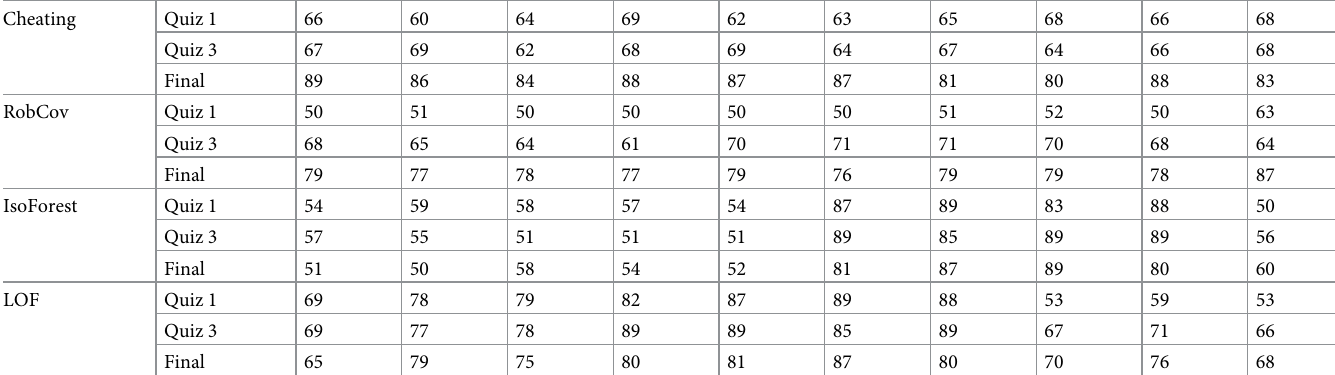
Table 5. The scores of the (true) cheating cases and the outlier cases determined by the detection methods in DS2 dataset.